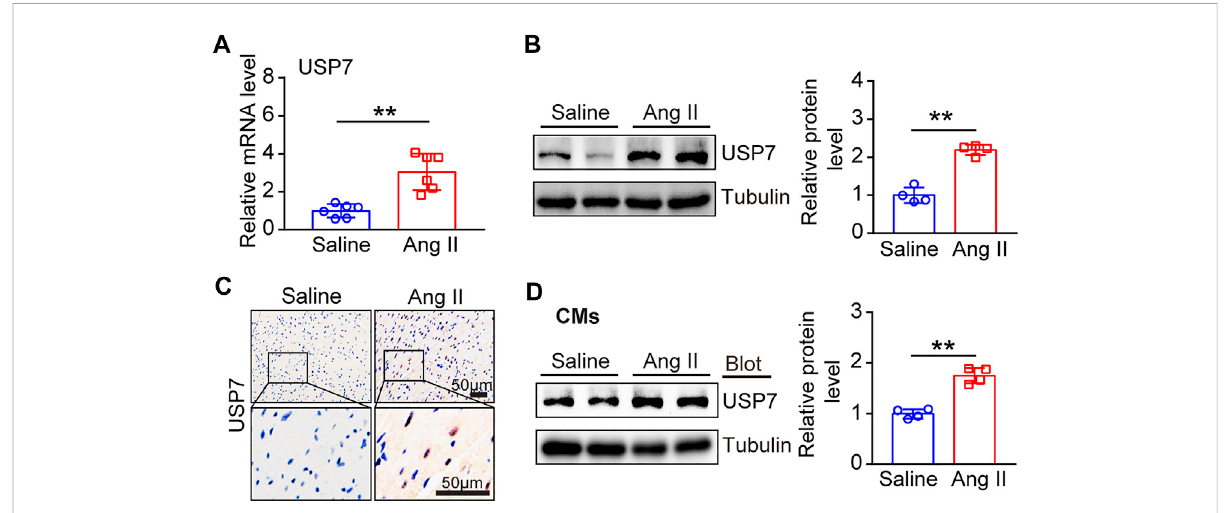
FIGURE 2 The expression of USP7 was upregulated in Ang II-induced hypertrophic hearts and myocytes. (A) qPCR analysis of USP7 mRNA expression in Ang II-infused mouse hearts ( n = 6). (B) Representative immunoblotting analysis of USP7 protein levels in Ang II (1,000 ng/kg/min) -induced hypertrophic hearts (left). Quanti fi cation of the relative USP7 protein level (right; n = 4). (C) Immunohistochemical staining of USP7 in Ang II (1,000 ng/kg/min)-infused mouse hearts ( n = 6). Scale bar: 50 μ m. (D) Representative immunoblotting analysis of USP7 protein level in NRCMs exposed to Ang II (100 nM) (left). Quanti fi cation of the relative USP7 protein level (right; n = 3). The data are presented as the mean ± SD, and n represents the number of animals per group. ** p < 0.01.